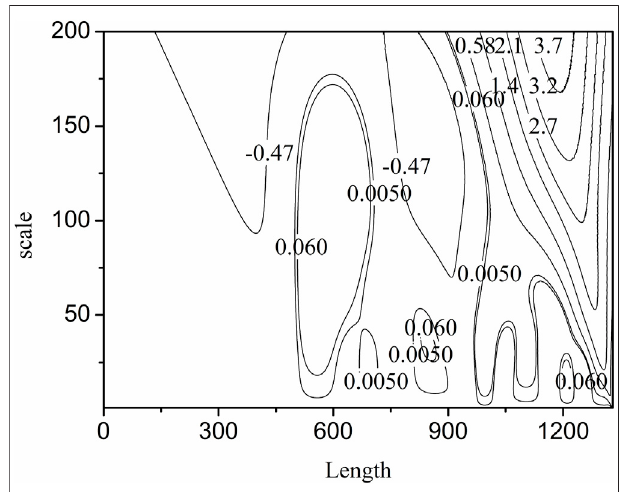
FIGURE 5 | The contour fi gure of the mexh WT results of the simulated signal.